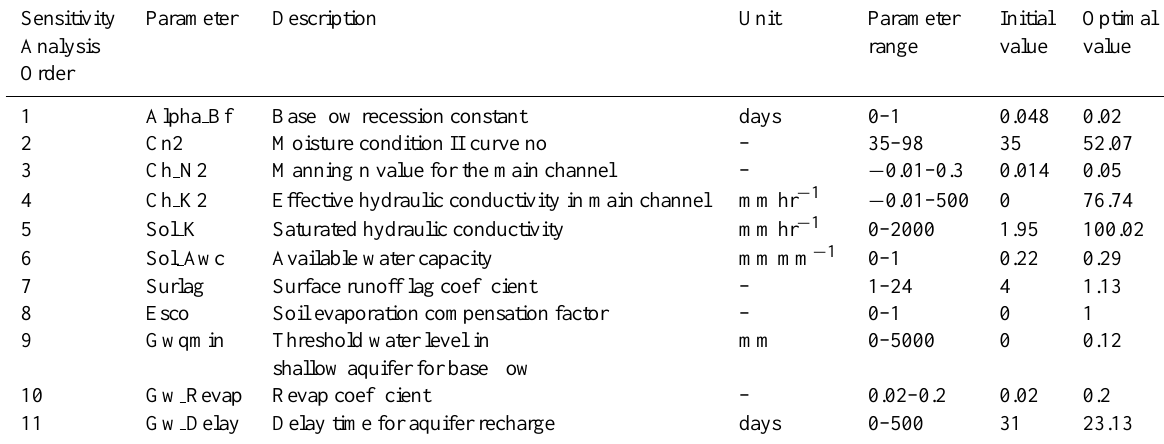
Table 2. Order of sensitive parameters and optimal value.